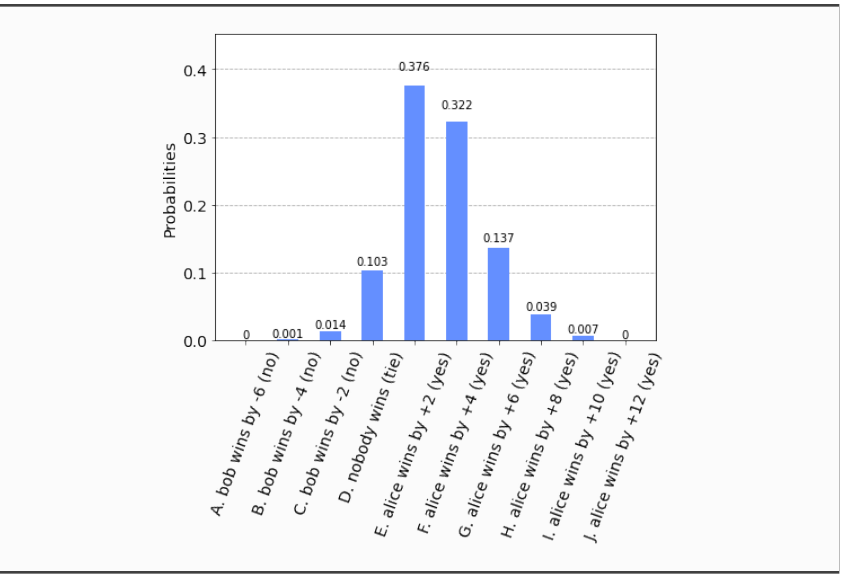
Figure 11. The possible outcomes and their probabilities when r A = 0.35 and r B =